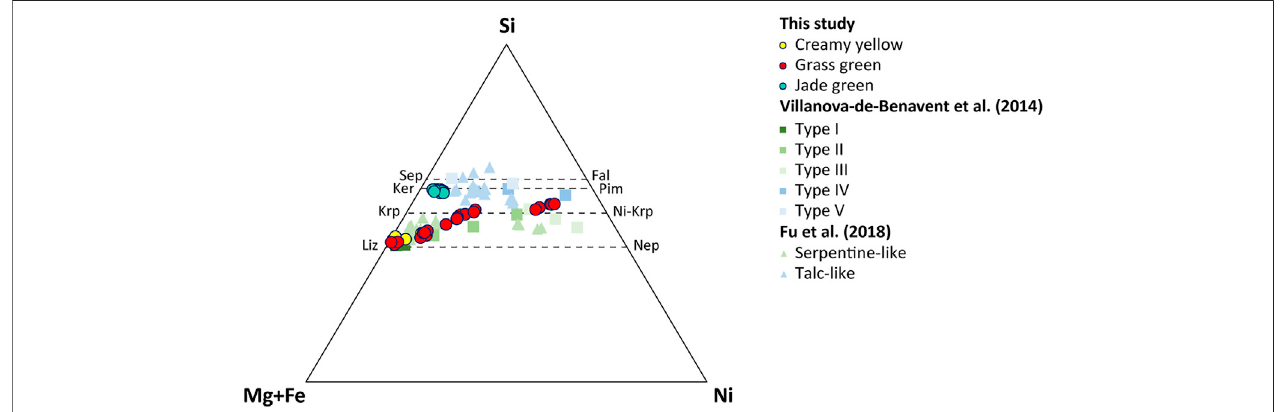
FIGURE 5 | Ternary diagram of Si-Mg + Fe-Ni system showing the garnierite phases in the Morowali deposit and other references. Abbreviation: Sep (cid:1) sepiolite, Fal (cid:1) falcondoite, Ker (cid:1) kerolite, Pim (cid:1) pimelite, Krp (cid:1) karpinskite, Liz (cid:1) lizardite, Nep (cid:1) népouite.